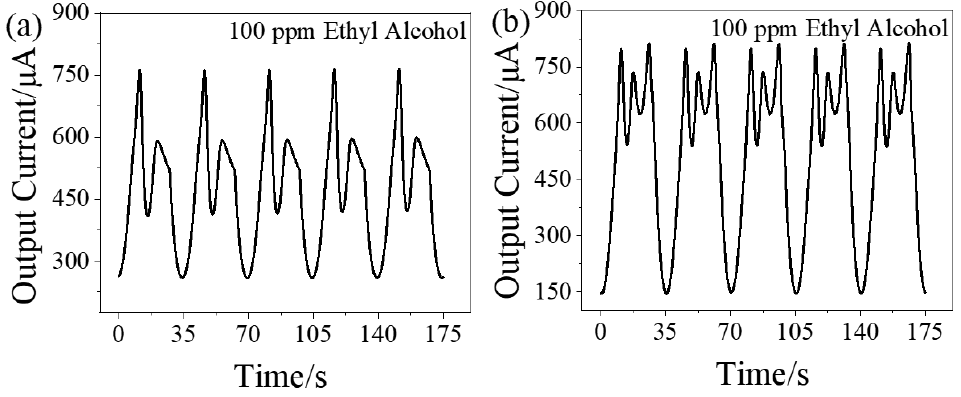
Figure 7. The dynamic response signal curves of ethyl alcohol-based on ( a ) TW-2 and ( b )